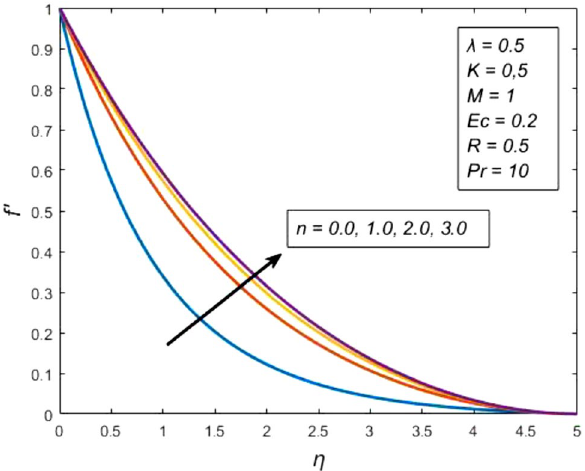
Figure 4. Impact of nonlinear stretching sheet parameter n on the velocity profile.